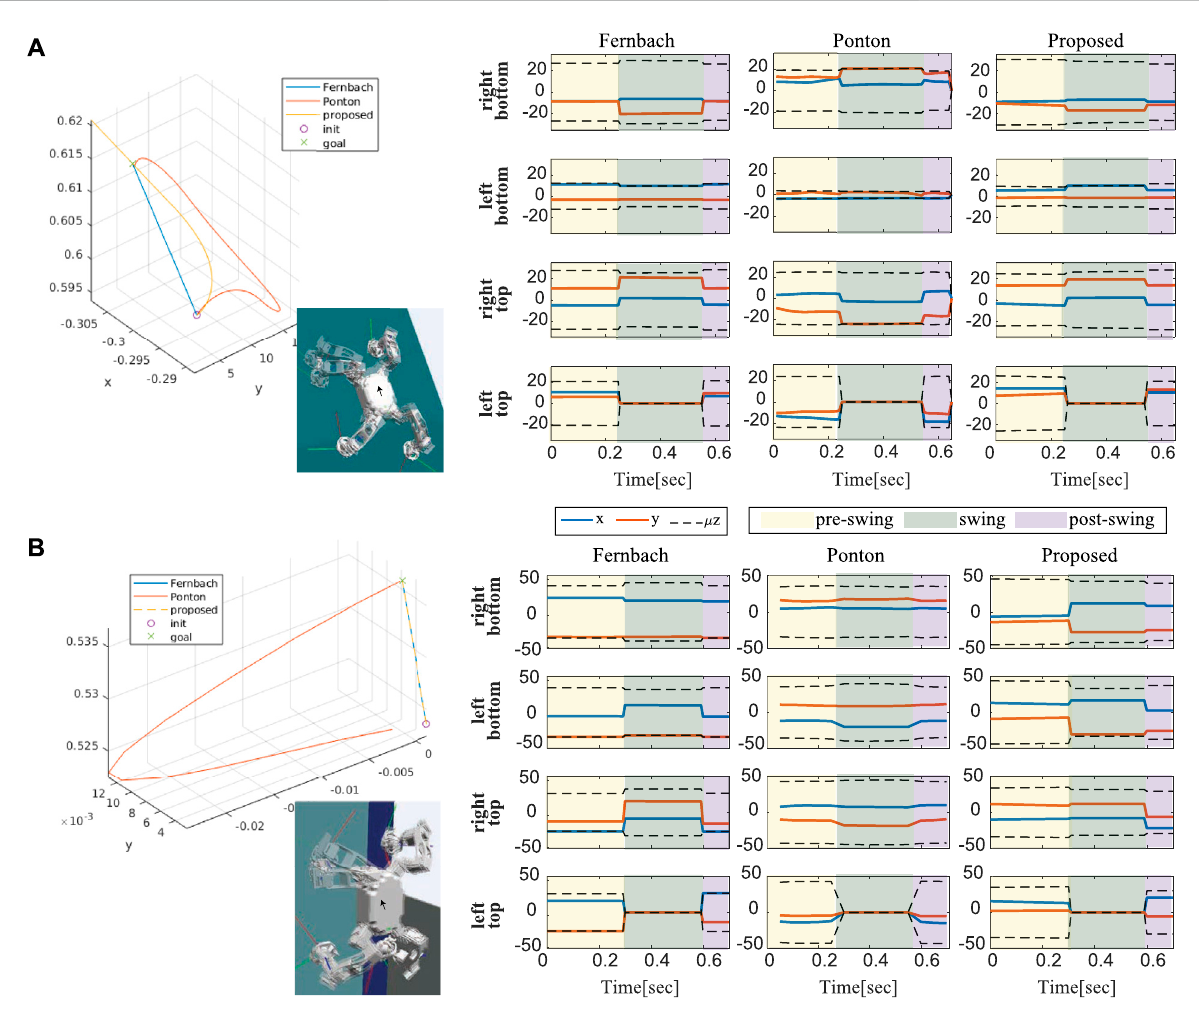
FIGURE 5 The comparison of centroidal climbing motion obtained by different algorithms. One-step climbing motions for the right top foot are compared on two structures [ (A) a fl at slope at α = 1 rad and (B) a hexagonal structure]. The plots on the right show the corresponding desired GRF distribution on each foot with friction inequality